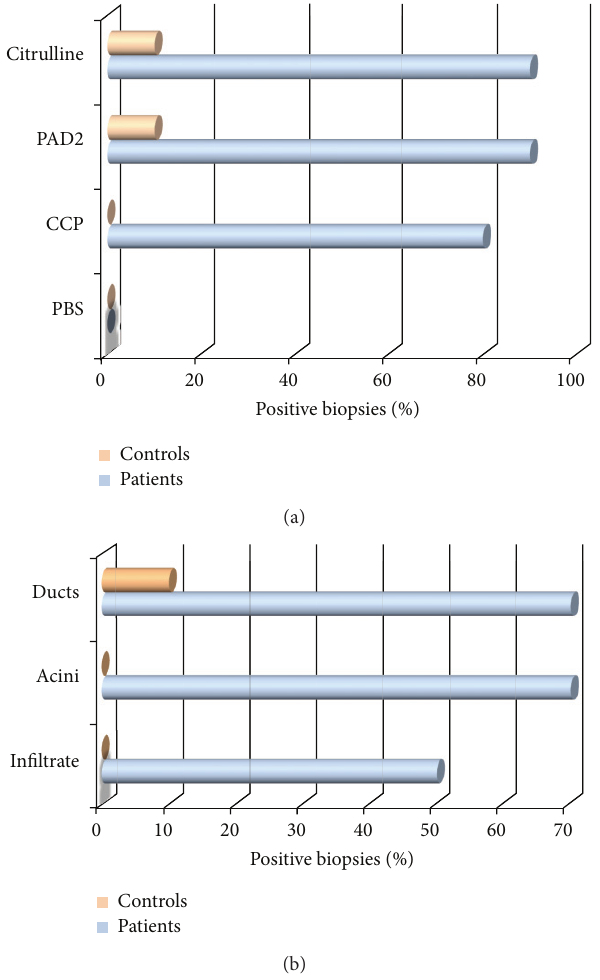
Figure 3: (a) Comparative immunohistochemistry assay of CCP, PAD2, and citrulline in controls and Sj¨ogren patients; note that 10% of normal biopsies express the PAD2 enzyme, while Sj¨ogren patients exclusively express CCP mutually distributed with PAD2. (b) Distribution of CCP/PAD2 in compartments of salivary glands of Sj¨ogren